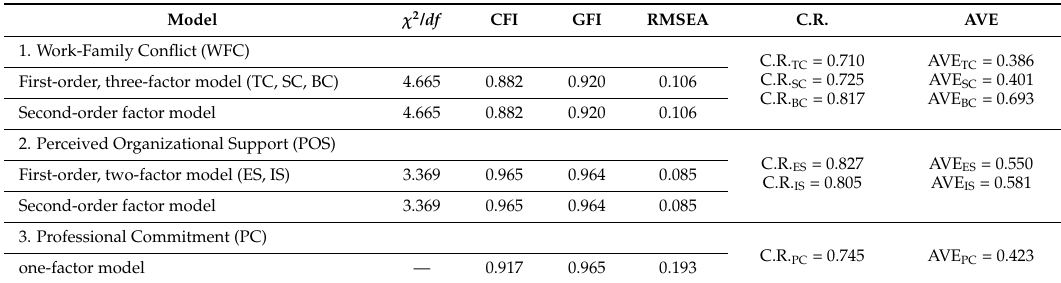
Table 3. Confirmatory factor analysis results.